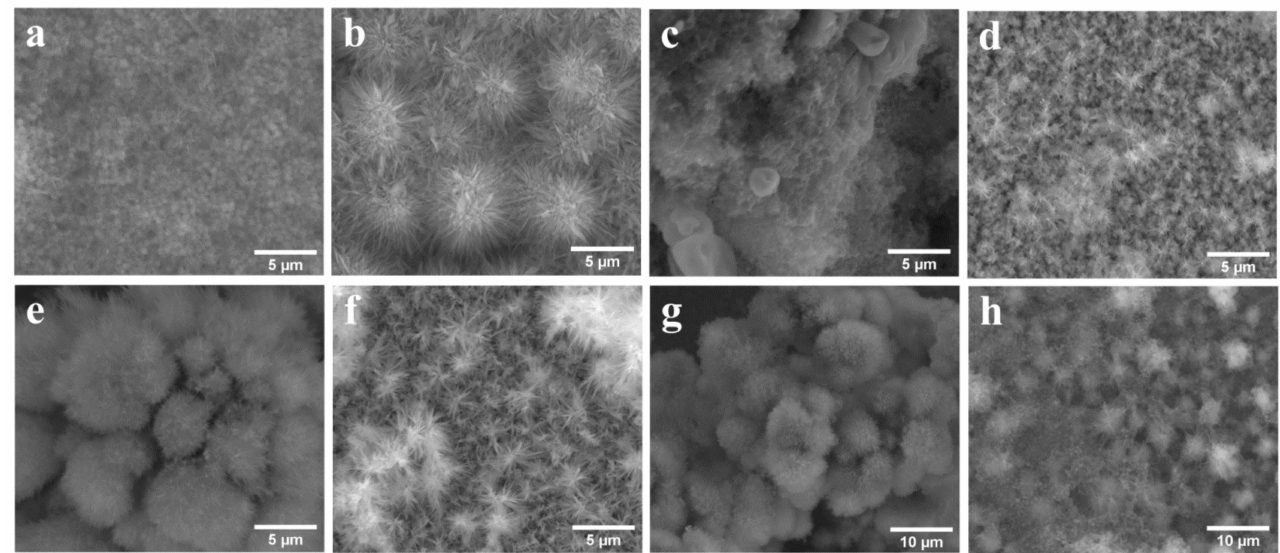
Figure 8. SEM images recorded on specimens HA13 ( a ), HA3 ( b ), HA14 ( c ), HA15 ( d ), HA16 ( e ), HA17 ( f ), HA18 ( g ), and HA19 ( h